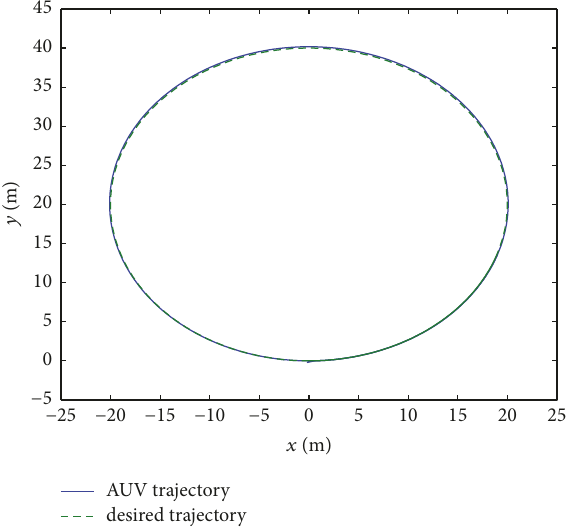
Figure 4: Path tracking response in 𝑥𝑦